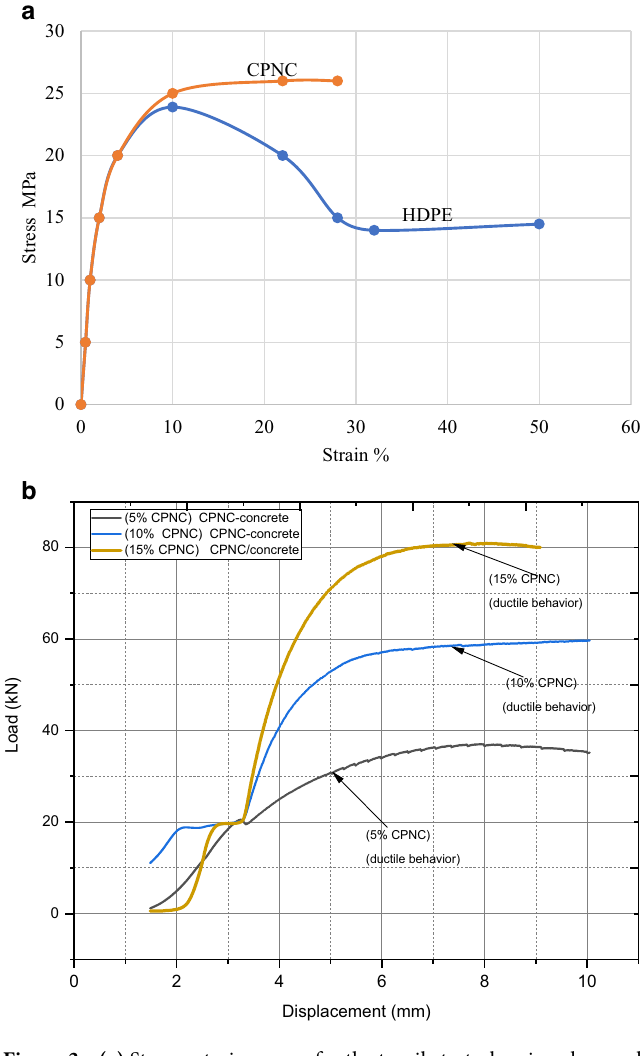
Figure 3. (a) Stress ‒ strain curves for the tensile test, showing changes between pure HDPE (M40060) and CPNC (HDPE and MMT) behaviours. ( b) Load ‒ displacement curves of the compression test of CPNC concrete, showing ductile behaviour.